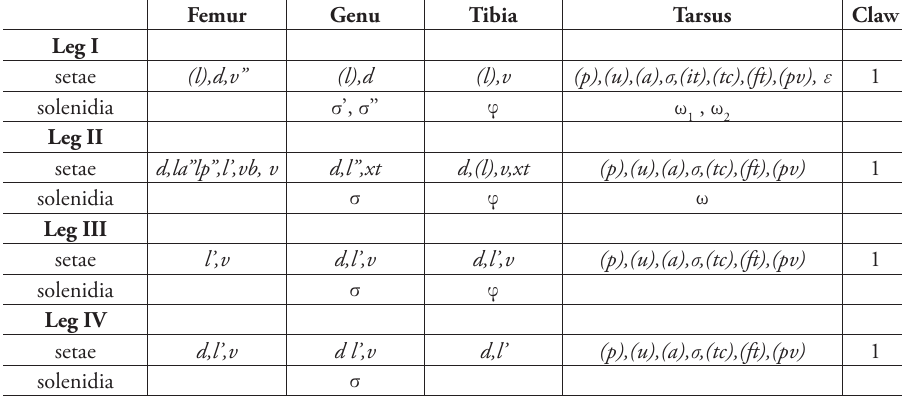
Table 2. Paulianacarus costaricensis sp. n.: setae and solenidia. Femur Genu Tibia Tarsus Cla